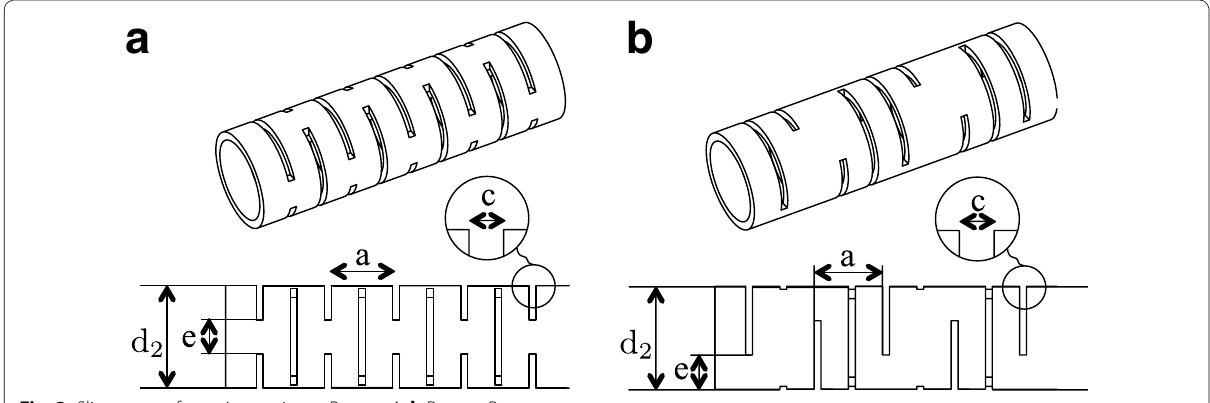
Fig. 3 Slit patterns for an inner pipe. a Pattern A. b Pattern